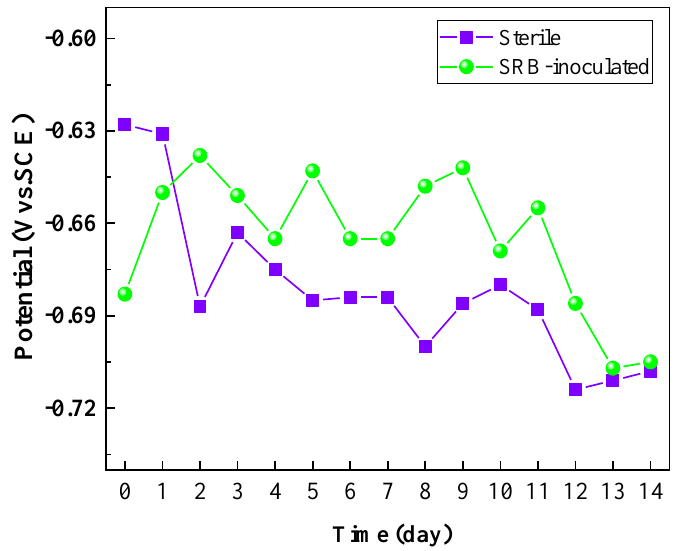
Figure 7. Time dependence of the potential for specimens in the abiotic and inoculated soil solutions over 14 days.